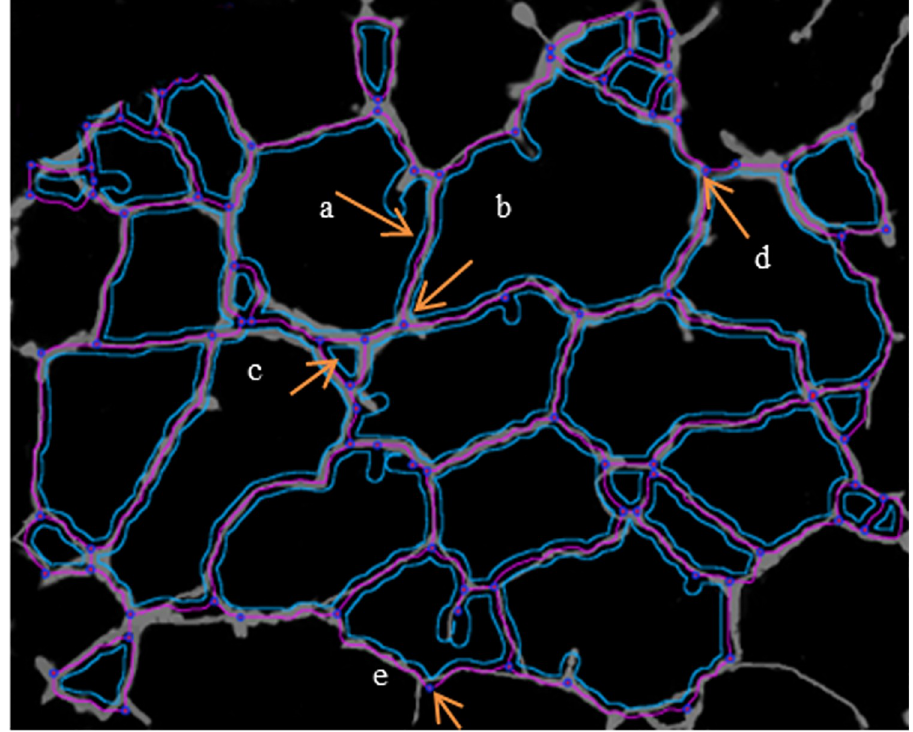
Fig 9. The detection of constitutive elements of the network—Summary. A tree composed from master segment (a); associated by master junction (b); delimiting the meshes (c); junction (note that this pointed junction is composed by several nodes) (d); node identified as three neighbors